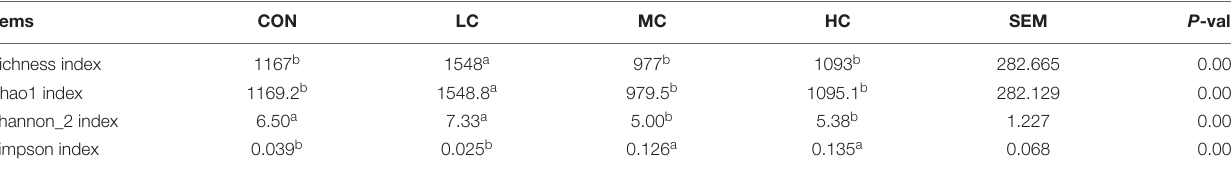
TABLE 1 | Alpha diversity